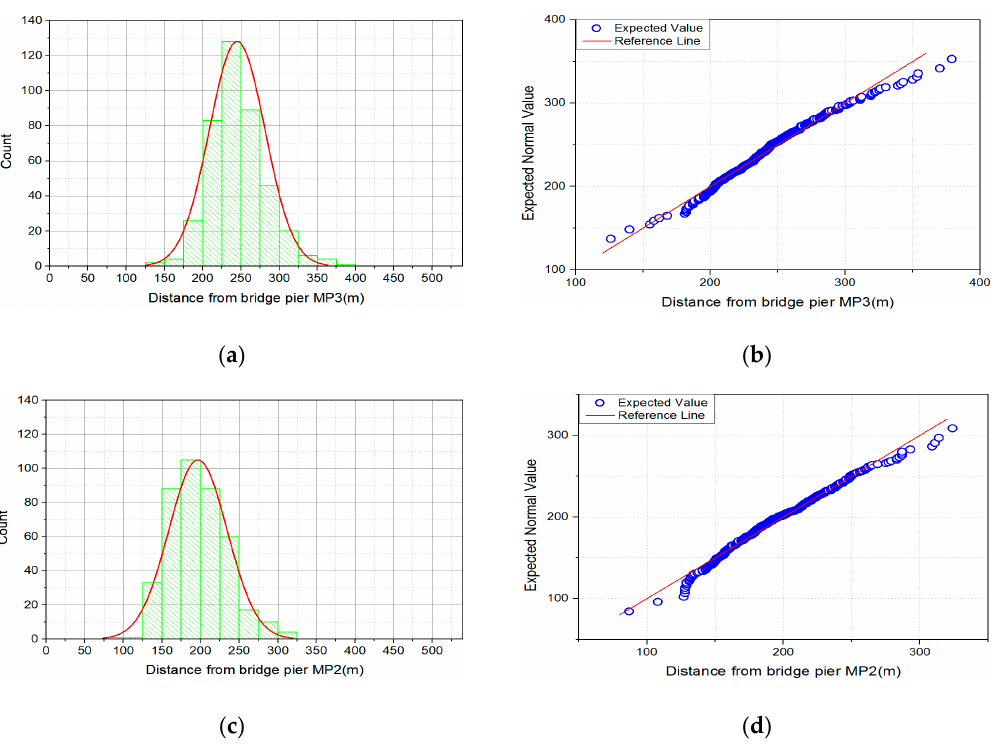
Figure 10. Histogram and Normal Q–Q plots for the Busan harbor bridge data for ( a , b ) arrival and ( c , d ) departure.